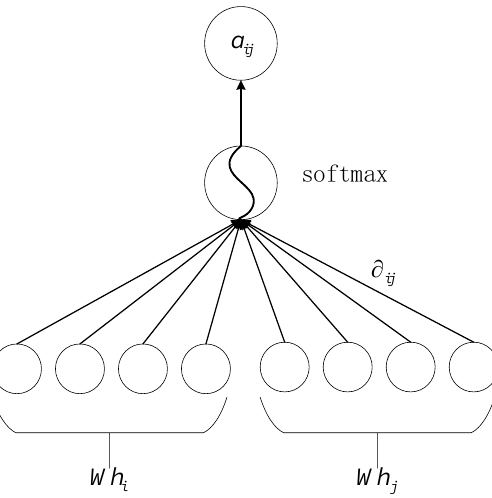
Figure 4. Attention calculation diagram.